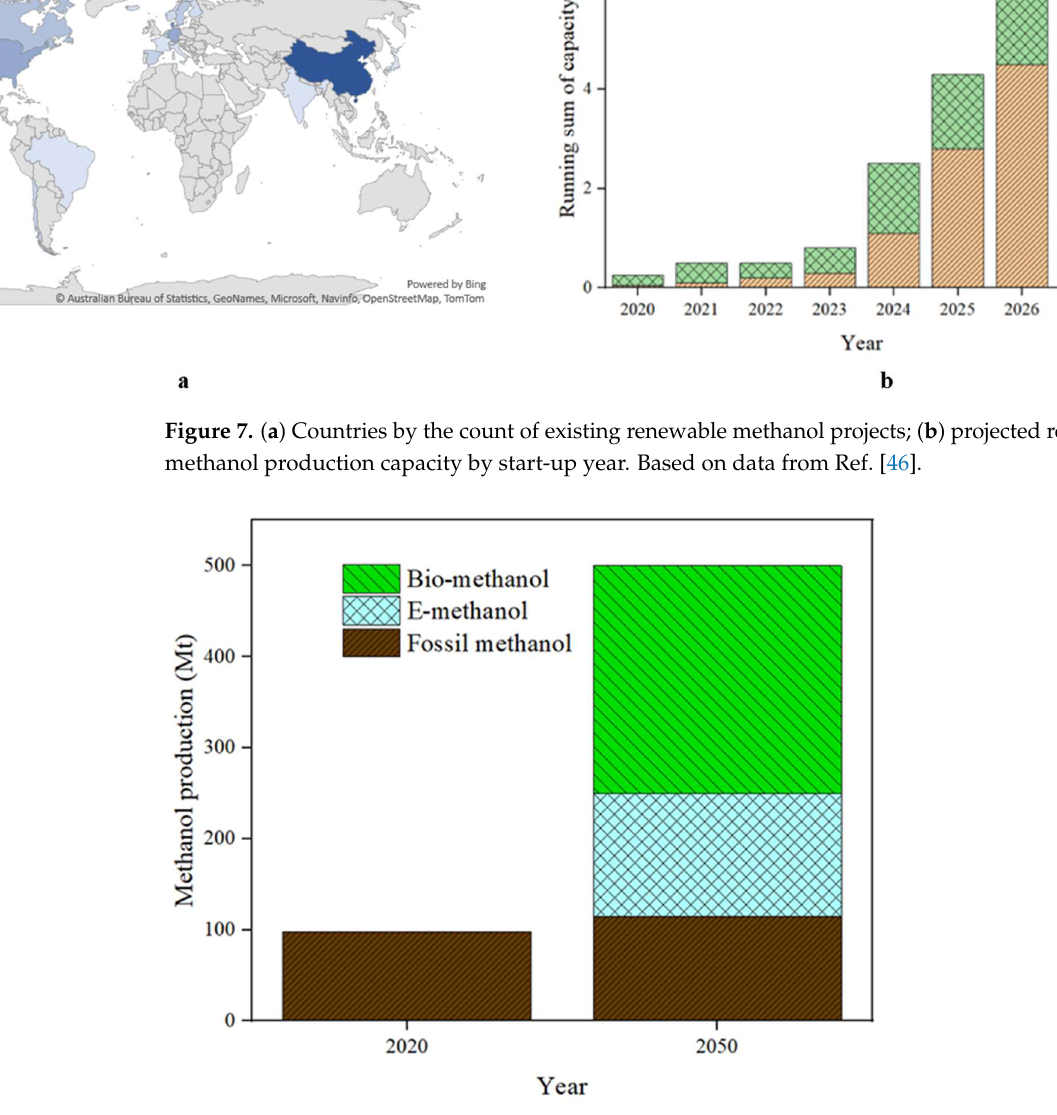
Figure 8. Production capacity of fossil and renewable methanol by 2050. Based on data from Ref. [47].